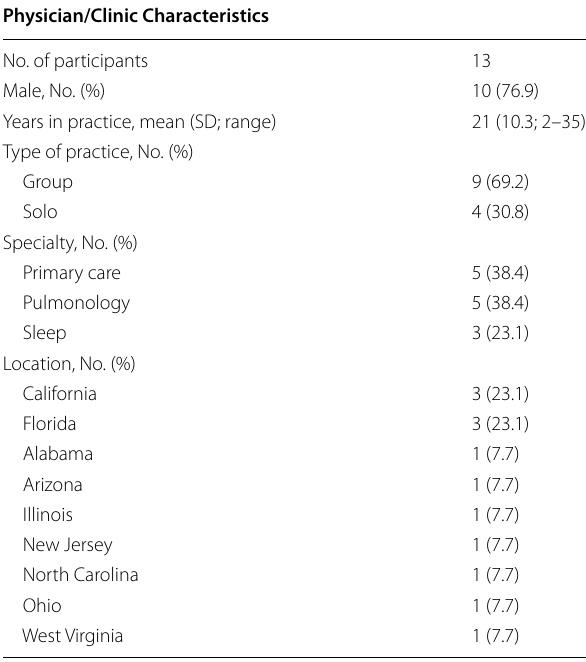
Table 1 Characteristics of participating physicians